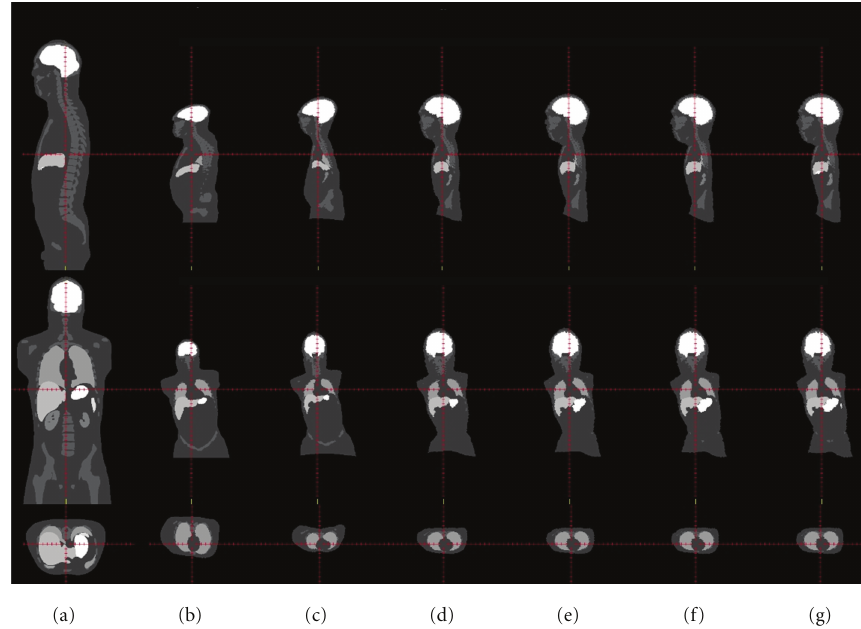
Figure 2: The robust sequence of transformations leading to the final mapping. Top row: sagittal slice, middle row: coronal slice, bottom row: axial slice. (a) Initial placement, (b) after a ffi ne registration, (c) after LDDMM landmark, and (d)–(g) after 1–4 iterations of MC-LDDMM.